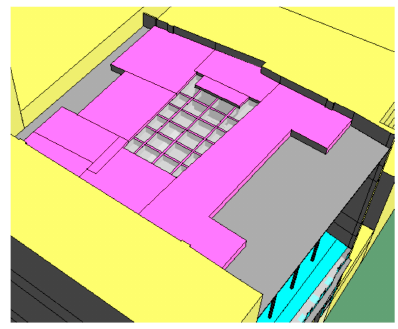
Figure 4. Skylight internal louvers’ configuration.